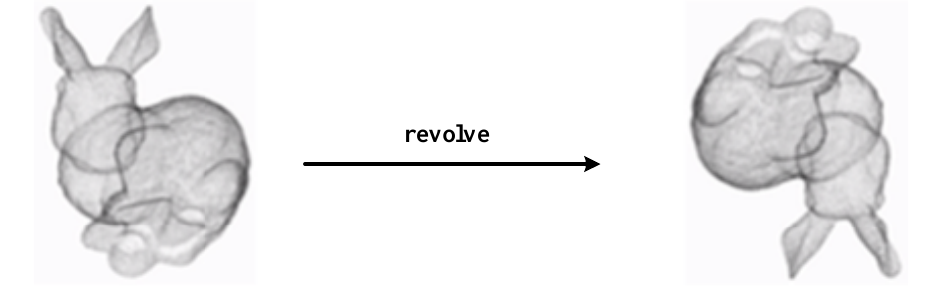
Figure 4. Rotation of an object.